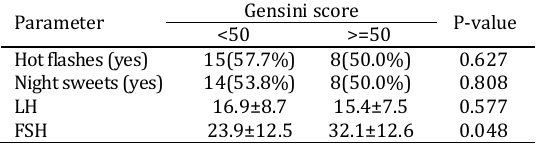
Table 1. Statistical analysis of clinical parameters Parameter